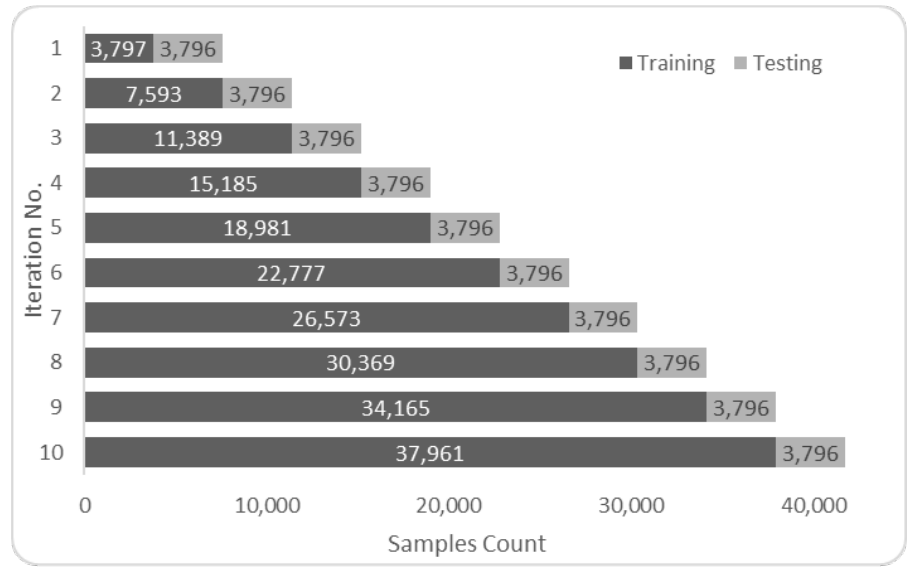
Figure 9. Training vs. testing in timeseries split cross-validation n =10 for the Beijing dataset.